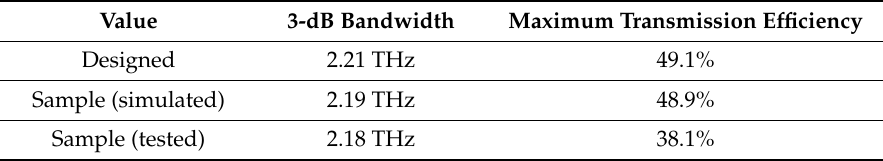
Table 1. Comparison of actual production and theoretical design of the filtering effect of the terahertz wideband